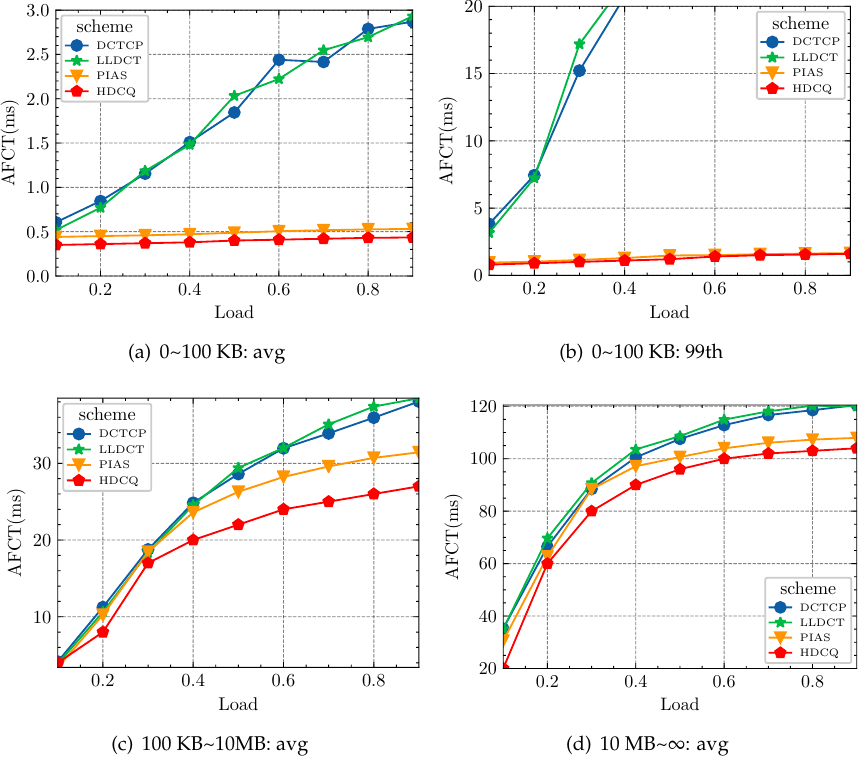
Figure 12. Web search workload: FCT across different flow sizes. The performance of DCTCP and LLDCT is outside the plotted range of ( b